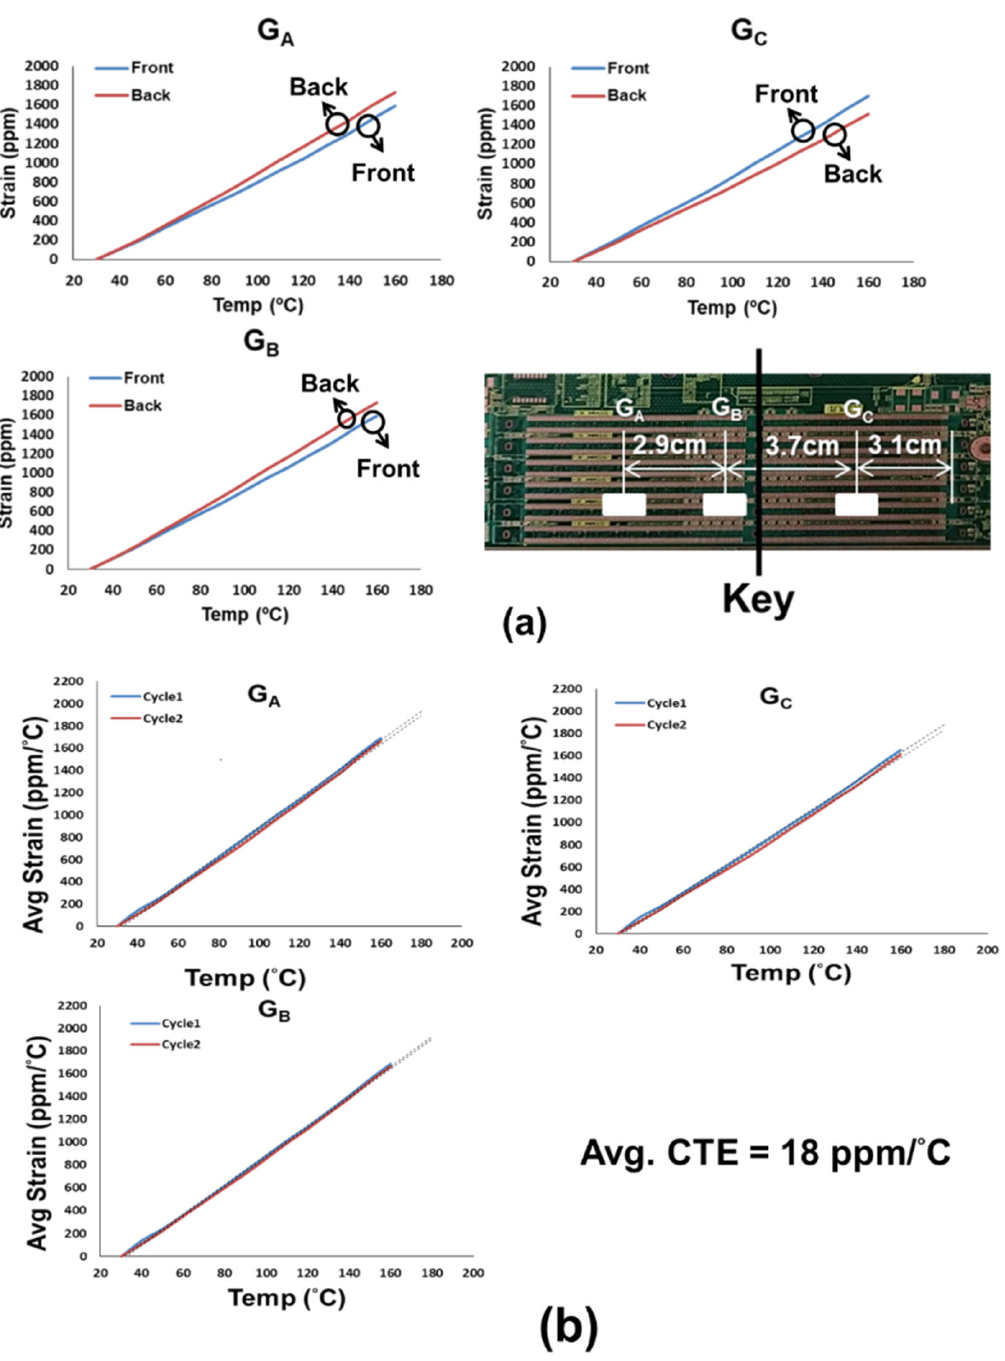
Figure 11. ( a ) Typical strain data from three pairs of front and back gauges (G A , G B , and G C ) on the bare PCB under thermal loading, and ( b ) average strains from front and back gauges for those three pairs during two thermal cycles and the CTEs of the PCB obtained from those average strain